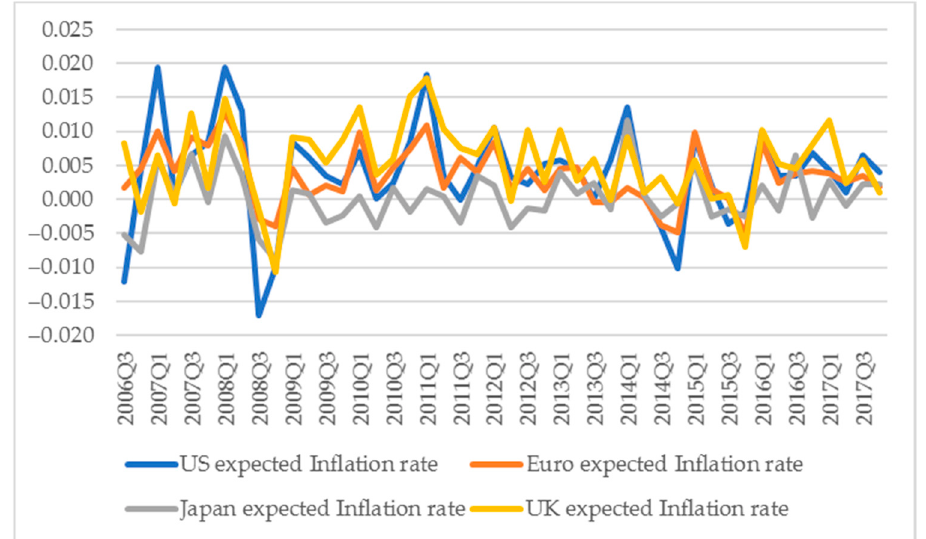
Figure 3. Expected inflation rate. Notes: The expected inflation rates are calculated rate of change between actual price level and expected price level estimated under the assumption that the price level of each period follows ARIMA (p, d, q) process. The price level data is CPI.